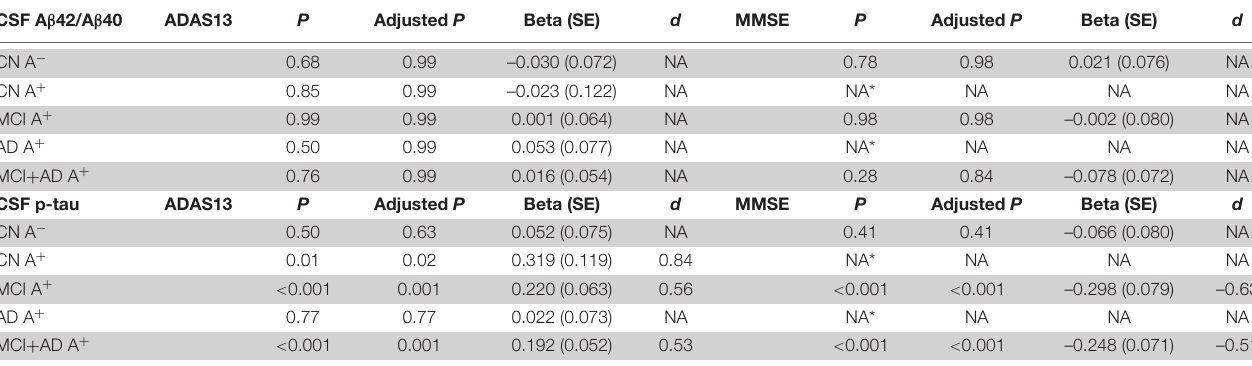
TABLE 4 | Statistical analysis of linear mixed-effect regression for CSF A β 42/A β 40 and CSF p-tau concentration in amyloid positive (A + ) groups alone or in